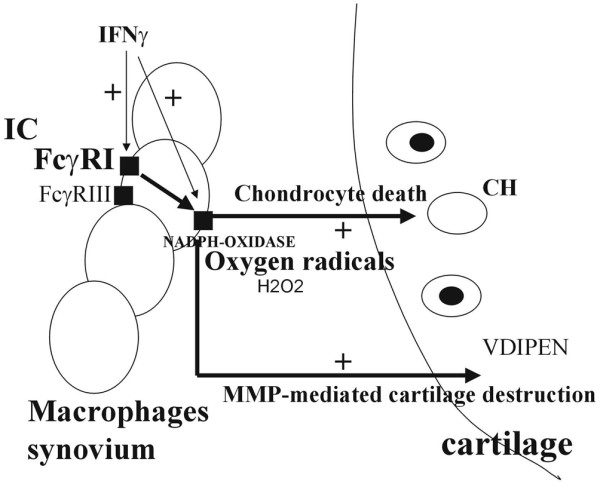
Possible involvement of NADPH oxidase in mediating cartilage destruction during ICA. Immune complexes (ICs) bind to FcγRI and FcγRIII expressed on macrophages, and cause the activation of NADPH oxidase. IFN-γ strongly elevates the expression of mainly FcγRI and NADPH oxidase. Oxygen radical production causes chondrocyte (CH) death and the activation of matrix metalloproteinases (MMP), leading to matrix degradation in the cartilage expressed as VDIPEN epitopes.